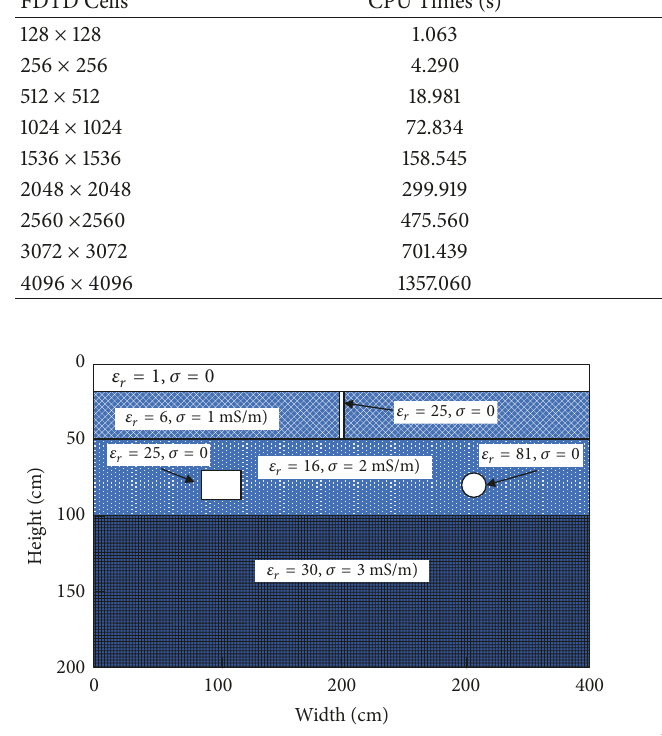
Figure 15: GPR trace profile with CUDA-implemented FDTD method.